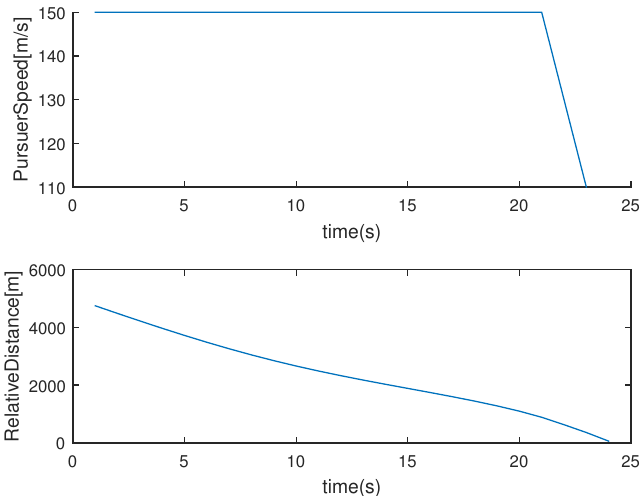
Figure 9. The ( top ) figure depicts the pursuer’s speed with respect to time. The ( bottom ) figure depicts the distance between the evader and the pursuer with respect to time (maneuvering